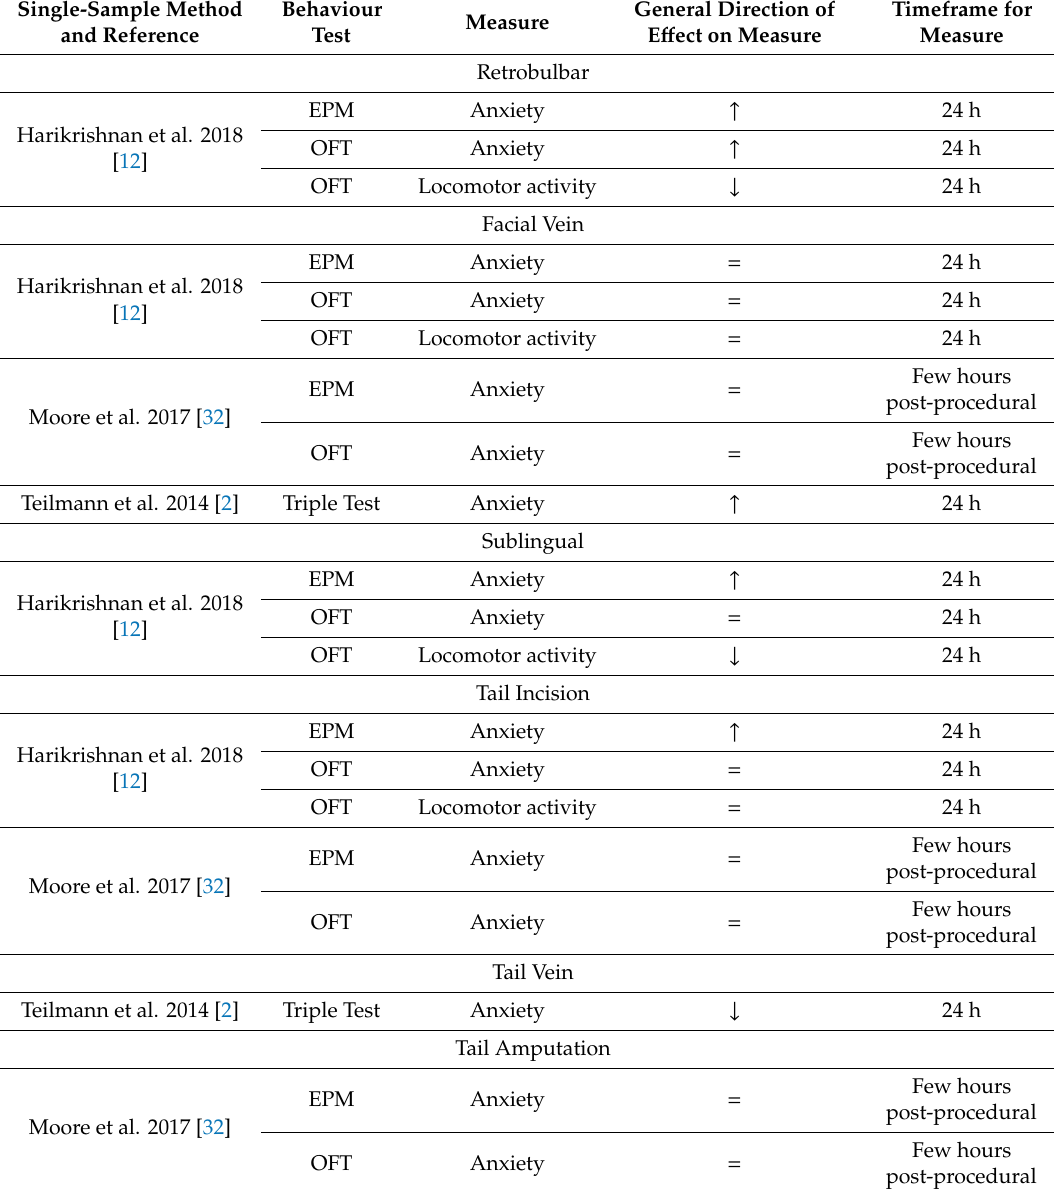
Table 4. Summary of direction of e ff ect for behavioural tests elevated plus maze (EPM) and open field test (OFT) when compared to sham / unmanipulated controls or baseline